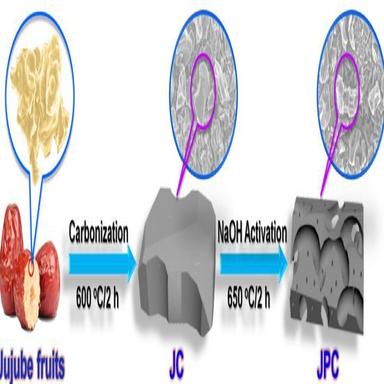
Synthetic illustration of the JPC from jujube fruits by the employing combined method of carbonization and activation processes.